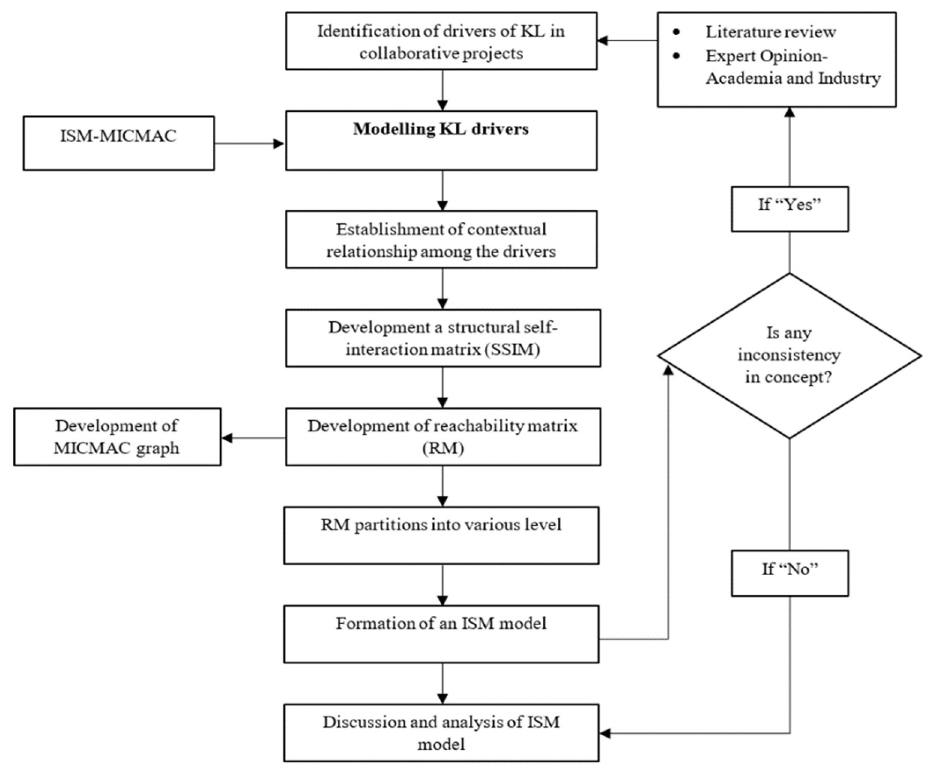
Figure 1. Steps in the research methodology.